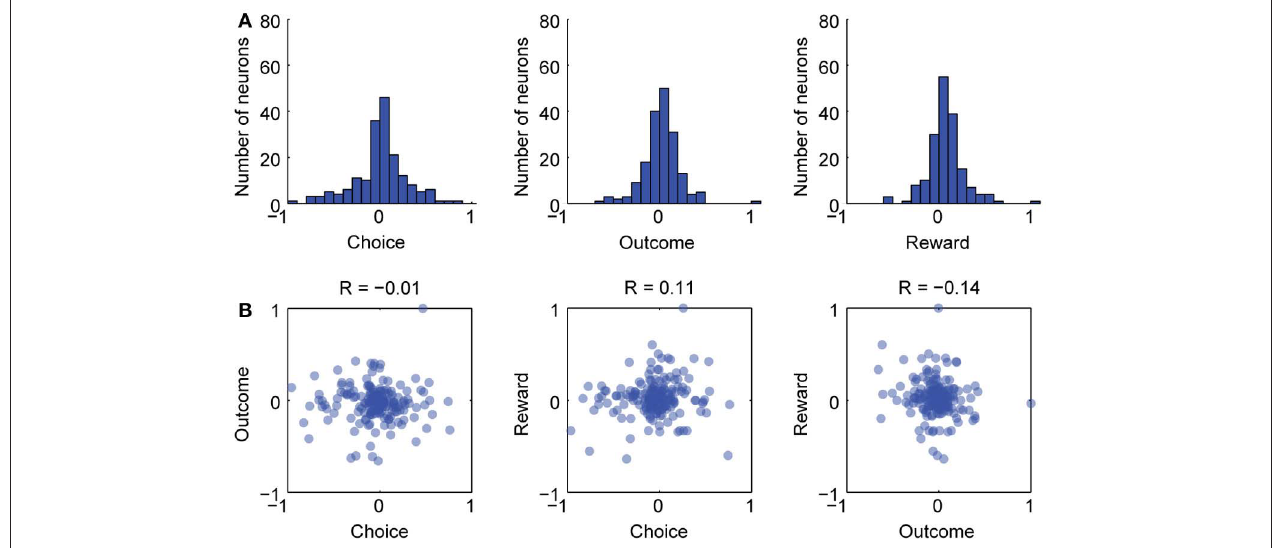
was no clear linear relationship between the indices over neurons. Therefore, there were few, if any, neurons that covaried across choice, outcome, and reward delivery. Pearson correlation coefficients ( R -values) are given for each scatterplot and none were significant at p < 0 .